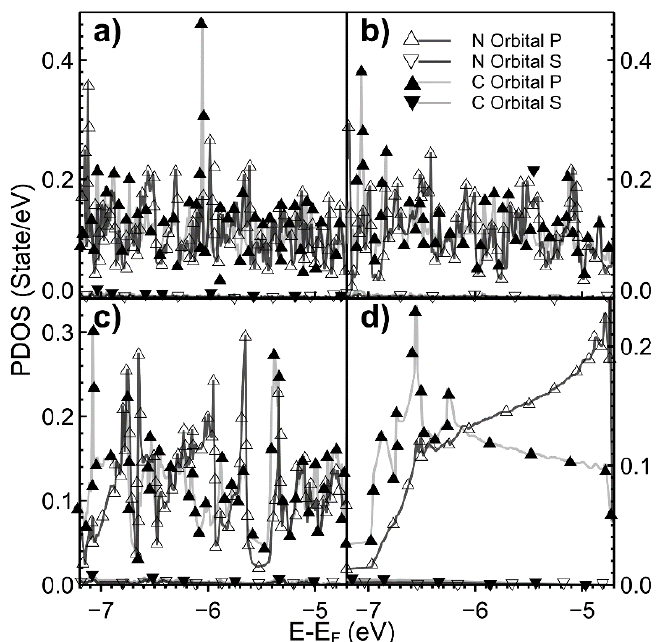
Figure 7. We show the PDOS for different values of vacancy densities when the dopant is nitrogen again. The energy range is from − 7.0 eV to − 5.0 eV. ( a ) 2.00%; ( b ) 3.12%; ( c ) 5.55%; ( d ) 12.5%. For carbon: orbital s : (cid:72) ; and for orbital p : (cid:78) . For nitrogen: orbital s : (cid:53) ; and orbital p : (cid:52) . The orbitals s for nitrogen and carbon are close to zero.